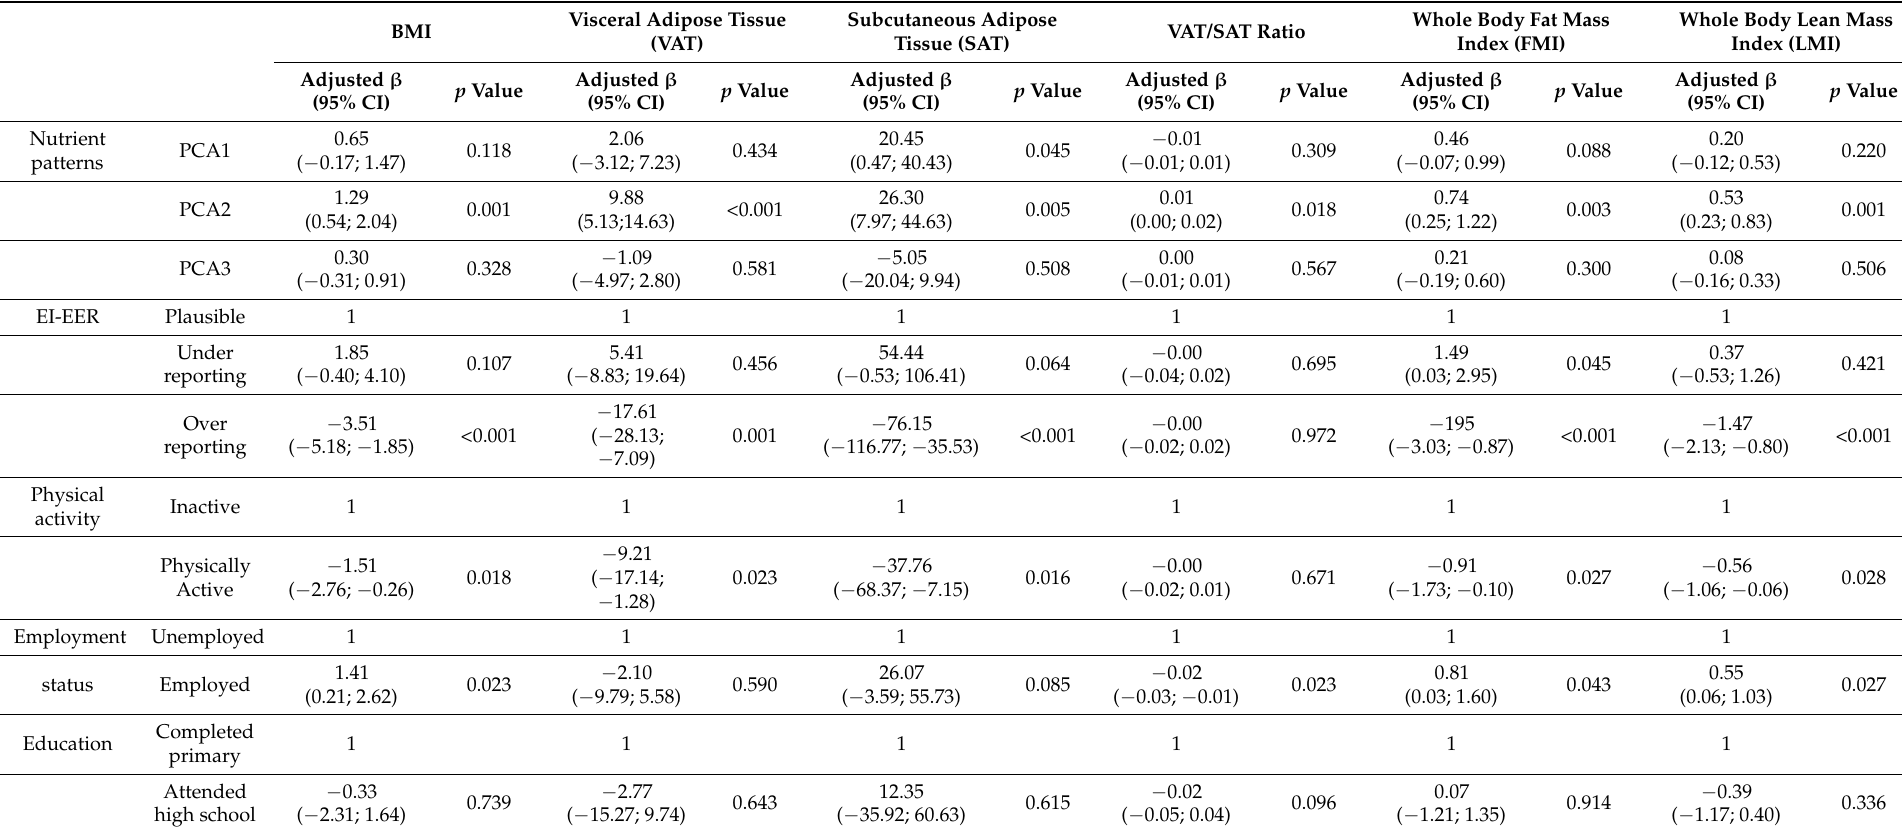
Table 3. Multivariable linear regression models showing the association of body composition indicators (BMI, VAT, SAT, VAT/SAT, FMI, and LMI; outcome variables) with the three nutrient patterns (predictor variables) and possible confounding factors (energy intake reporting, physical activity, employment status, education, smoking, and alcohol